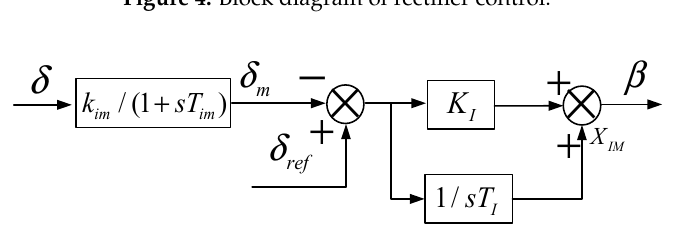
Figure 5. Block diagram of inverter control.